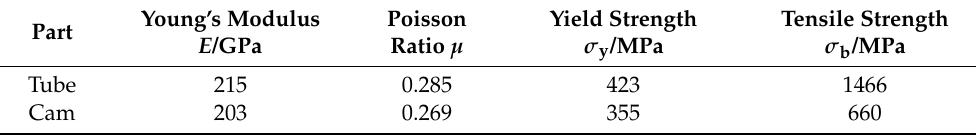
Table 2. Mechanical properties of SUS304 tube and 45 steel